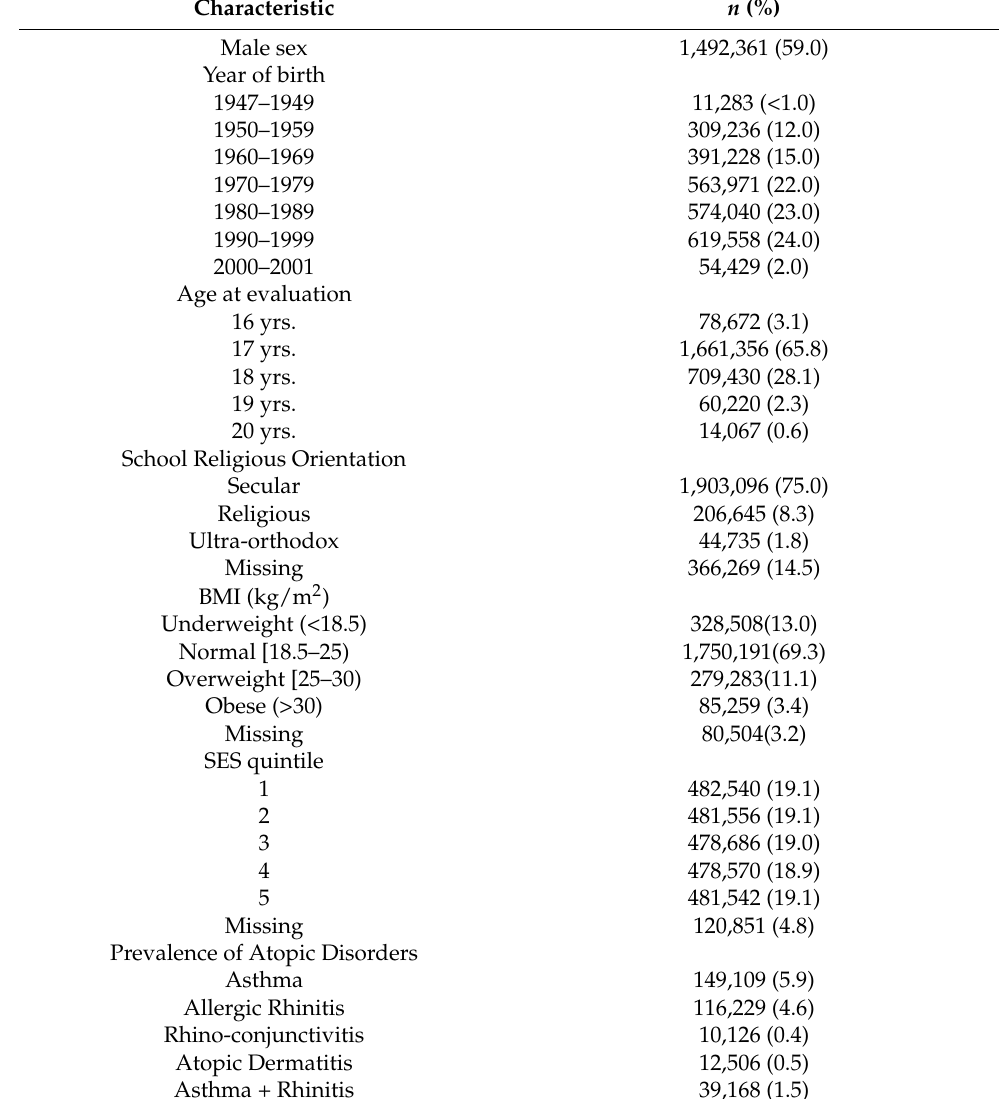
Table 1. Characteristics of the Population, Israel,